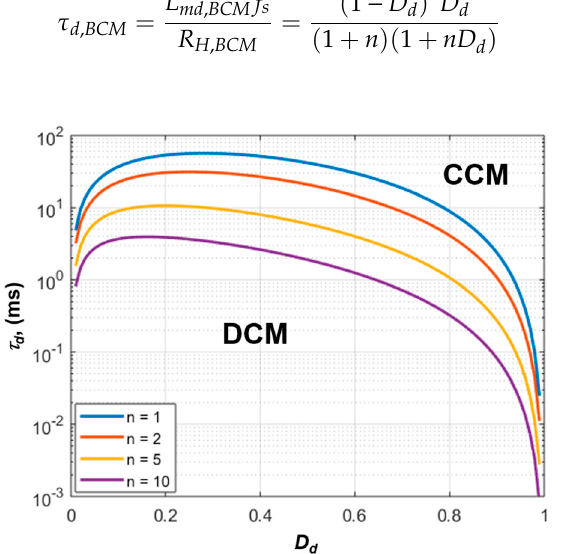
τ d,BCM in the discharge